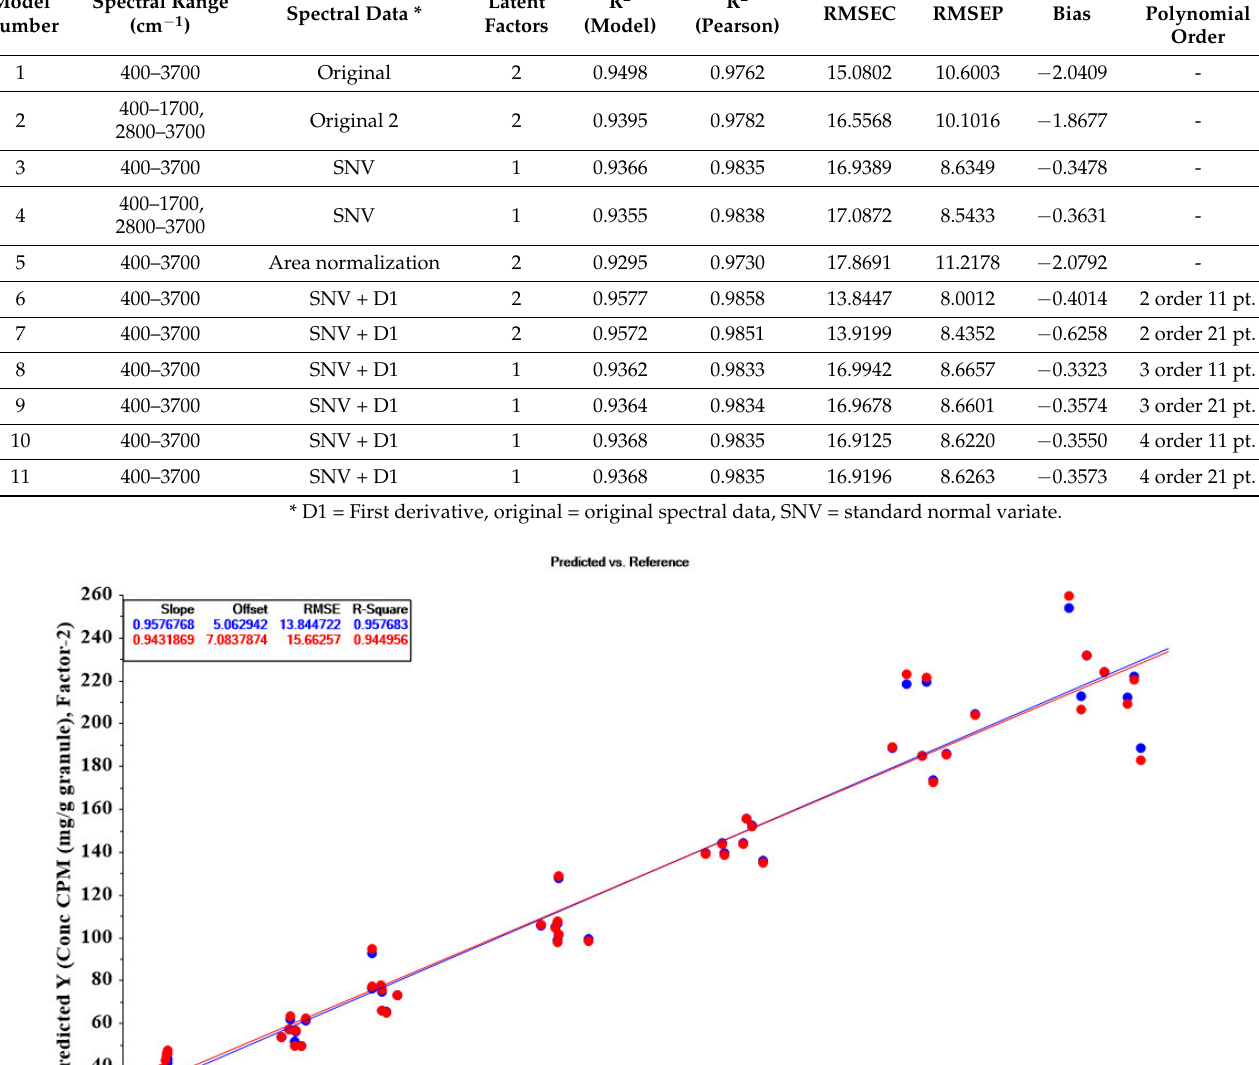
Figure 4. Plots of calibration and cross-validation of the optimum model for granules. Calibration and cross-validation samples indicating that the data are appreciated and modelled, the closer the